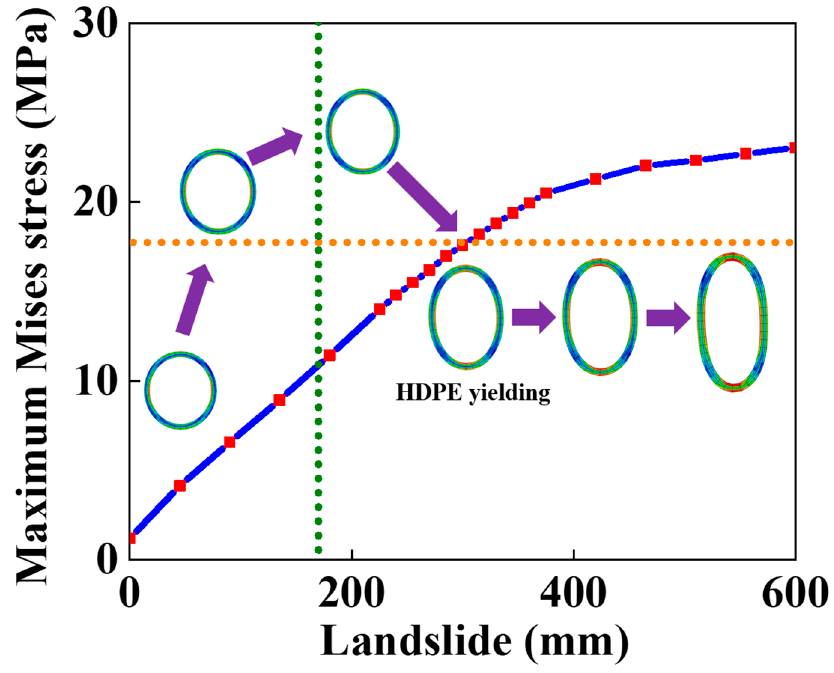
Figure 12. Variation in Maximum Mises stress in the HDPE matrix with the landslide.